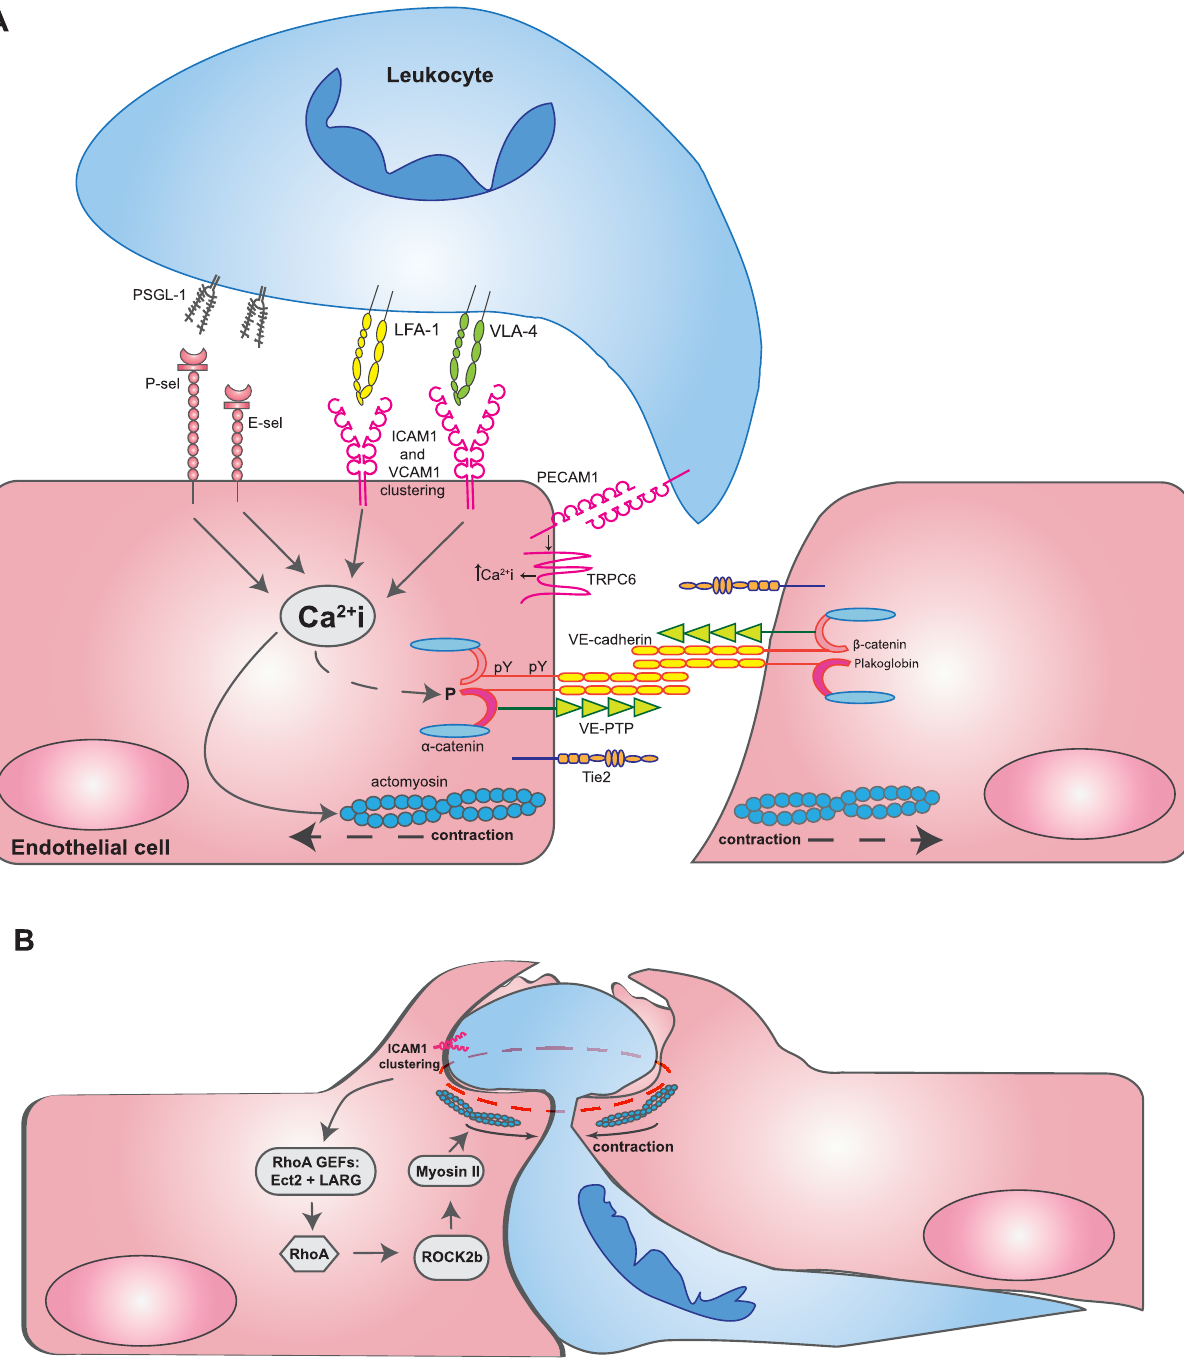
Figure 1. Opening and closing of endothelial junctions during diapedesis. ( A ) Leukocytes interacting with several adhesion molecules on the endothelial cell surface trigger Ca 2+ signals inside endothelial cells, which are essential for leukocyte transmigration. It was reported that Ca 2+ signals triggered by the apical adhesion molecules were initiated by stores from the endoplasmic reticulum but that PECAM-1 Ca 2+ transients occurred rather local at transmigration sites through the TRPC6 channel. Ca 2+ signals trigger the activation of actomyosin-mediated pulling on endothelial junctions, influence the phosphorylation of components of the VE-cadherin-catenin complex, and trigger the recycling of the lateral border recycling compartment (LBRC) vesicle compartment. For a more detailed depiction of intracellular signaling steps, the reader is referred to recent reviews 7–9 . ( B ) When leukocytes have already transmigrated more than halfway through the site of diapedesis, RhoA- mediated signaling triggered by the RHO guanine nucleotide exchange factors (GEFs) Ect2 and LARG stimulates ROCK2b, which activates actomyosin-based forces that support pore confinement, which leads to closure of the diapedesis pore 87 . Abbreviations: ICAM1, intercellular adhesion molecule 1; LFA-1, lymphocyte function-associated antigen 1; PECAM-1, platelet and endothelial cell adhesion molecule 1; PSGL-1, P-selectin glycoprotein ligand-1; TRPC6, transient receptor potential canonical-6; VCAM1, vascular cell adhesion molecule 1; VE-cadherin, vascular endothelial cadherin; VE-PTP, vascular endothelial protein tyrosine phosphatase; VLA-4, very late